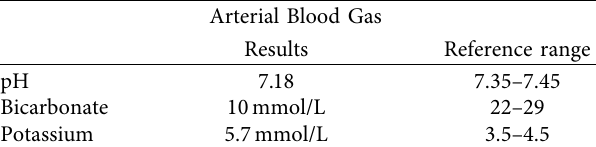
Table 2: Blood gas results.